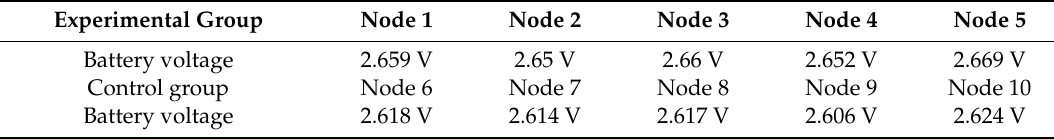
Table 5. The battery voltage of each node at the 69th